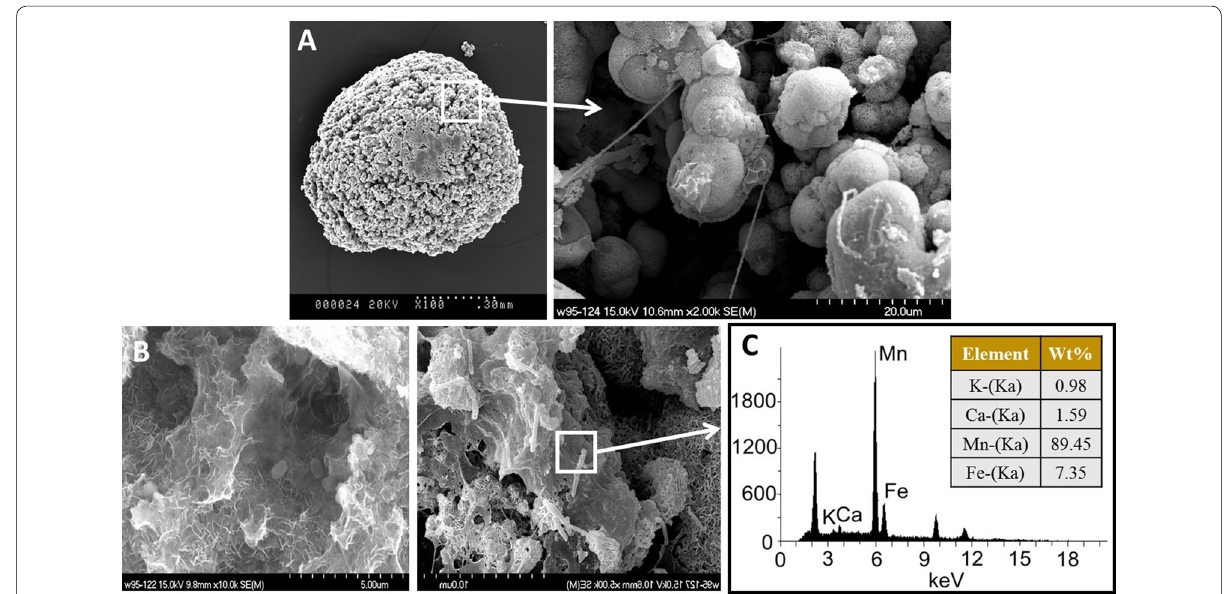
Fig. 2 SEM images of the mature manganese sand (